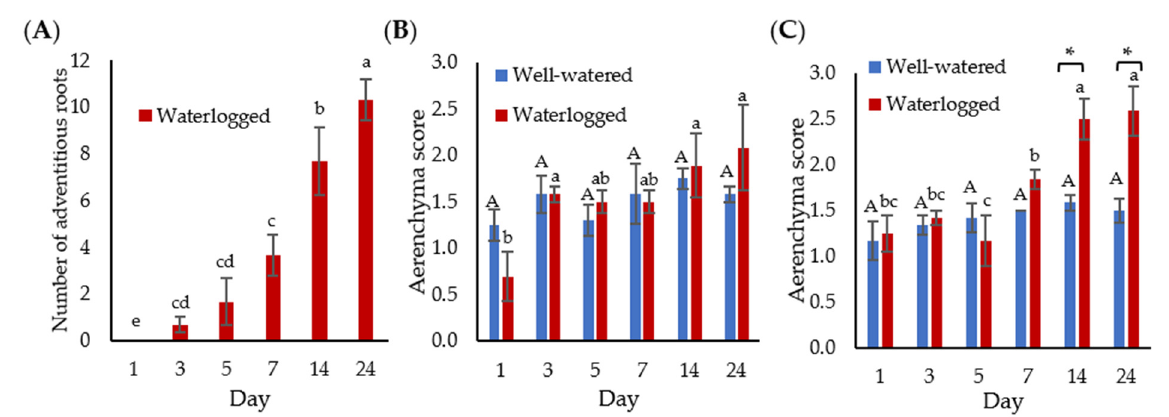
Figure 2. Adventitious root and aerenchyma formation. ( A ) The number of adventitious roots in well-watered and waterlogged banana plants. The mean aerenchyma score of ( B ) 5 cm from the root tip and ( C ) 5 cm from the root base. The results represent the mean ± standard error of the mean of nine independent biological replicates with three technical replicates each. Different capital letters indicate a significant difference between time points within well-watered samples. Different lowercase letters indicate a significant difference between time points within waterlogged samples. Asterisk (*) indicates a significant difference between well-watered and waterlogged samples at the same time point ( p < 0.05).